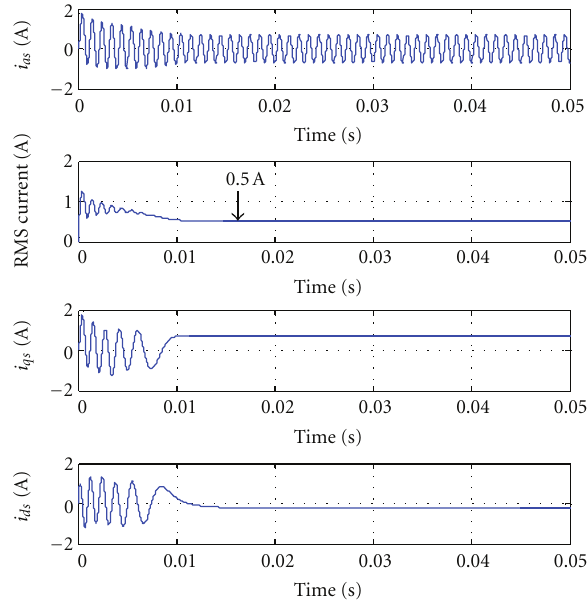
F 7: Stator current waveform at 60000 rpm at no-load